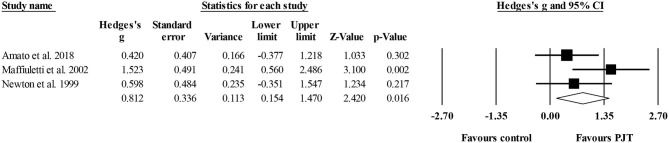
Forest plot of changes in drop jump performance in volleyball players participating in plyometric jump training (PJT) compared to controls. Values shown are effect sizes (Hedges's g) with 95% confidence intervals (CI). The size of the plotted squares reflects the statistical weight of the study.